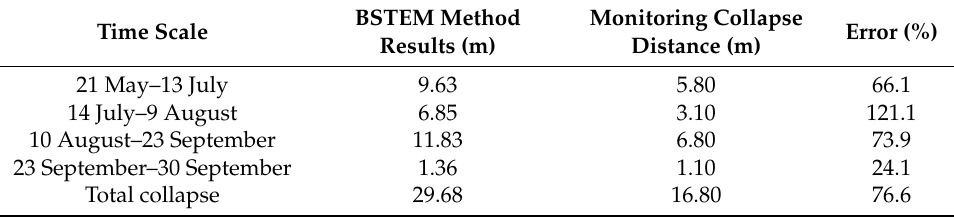
Table 13. BSTEM results, field measurements and errors for surveying Section 3.